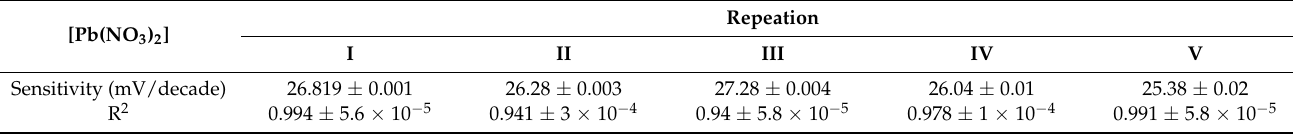
Table 4. Repeatability of Pb 2+ ISE with linear range Pb(NO 3 ) 2 solutions of 10 − 10 –10 − 5 M.